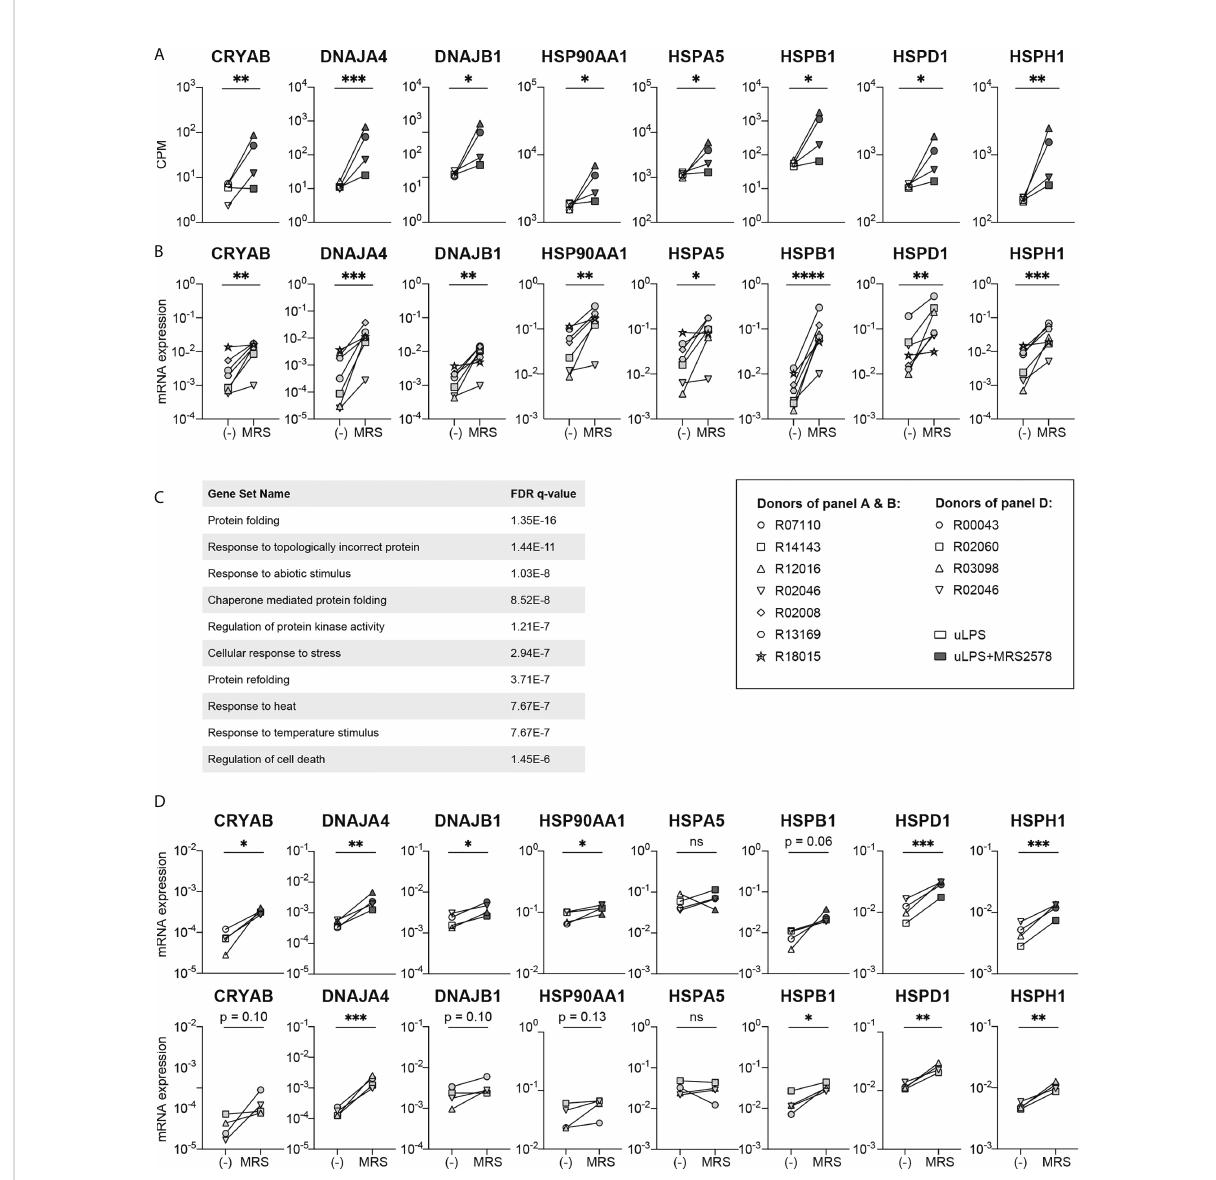
FIGURE 4 Exposure to P2RY6 antagonist MRS2578 induces the expression of heat shock protein genes. (A) Gene expression levels (CPM) of heat shock protein genes in microglia exposed to uLPS (TLR4), with (grey symbols) or without (white symbols) 1 h pre-incubation with MRS2578. n=4, EdgeR false discovery rates (FDR) are used to display statistical differences, * FDR < 0.05 ** FDR < 0.01 *** FDR < 0.005. (B) mRNA expression levels measured by RT-PCR of heat shock protein genes in homeostatic microglia and microglia exposed to 5 µM MRS2578. Symbols represent different donors. n=7, paired t-test on log-transformed data, *p < 0.05, **p < 0.01, ***p < 0.005, ****p < 0.001. (C) Biological processes associated with upregulated differentially expressed genes in uLPS exposed microglia in the presence of P2RY6 antagonist. FDR = false discovery rate. (D) mRNA expression levels measured by RT-PCR of heat shock protein genes in homeostatic BMDM and BMDM exposed to 5 µM MRS2578, either in the absence or presence of 10 ng/mL uLPS. Symbols represent different donors. n=4, paired t-test on log-transformed data, ns, not statistically signi fi cant, *p < 0.05, **p < 0.01, ***p <